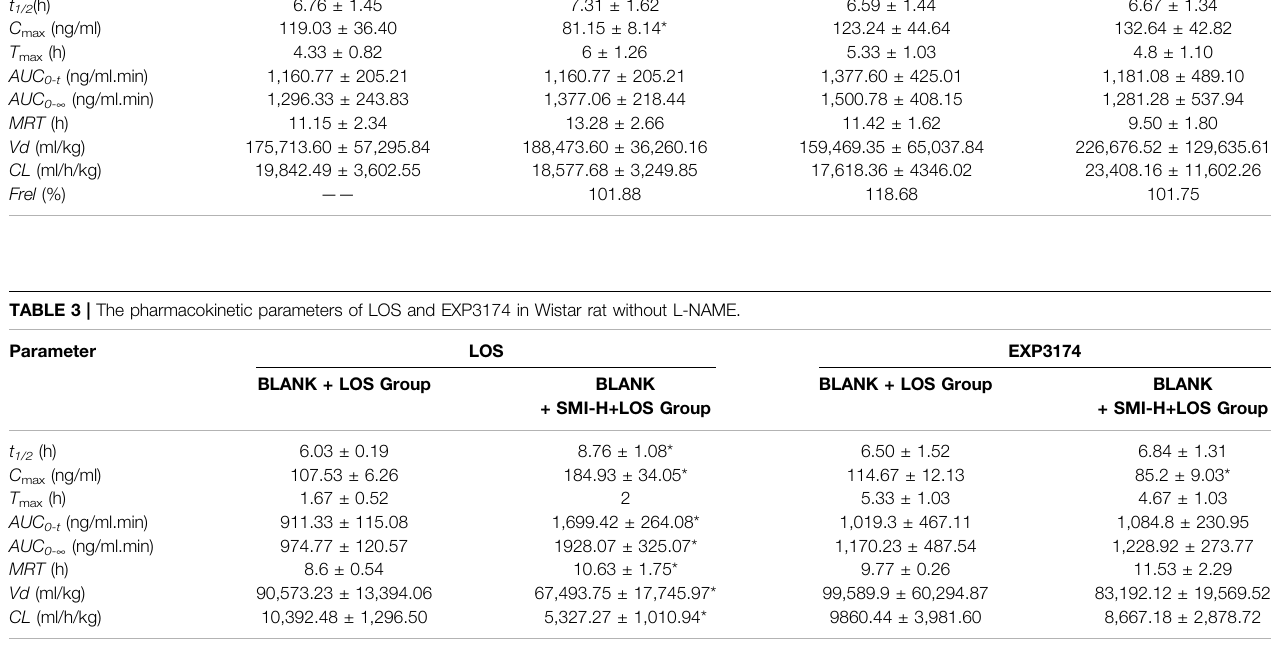
TABLE 2 | The pharmacokinetic parameters of EXP3174 with 6 weeks L-NAME treatment. * indicates p < 0.05 compared with LOS group. Parameter